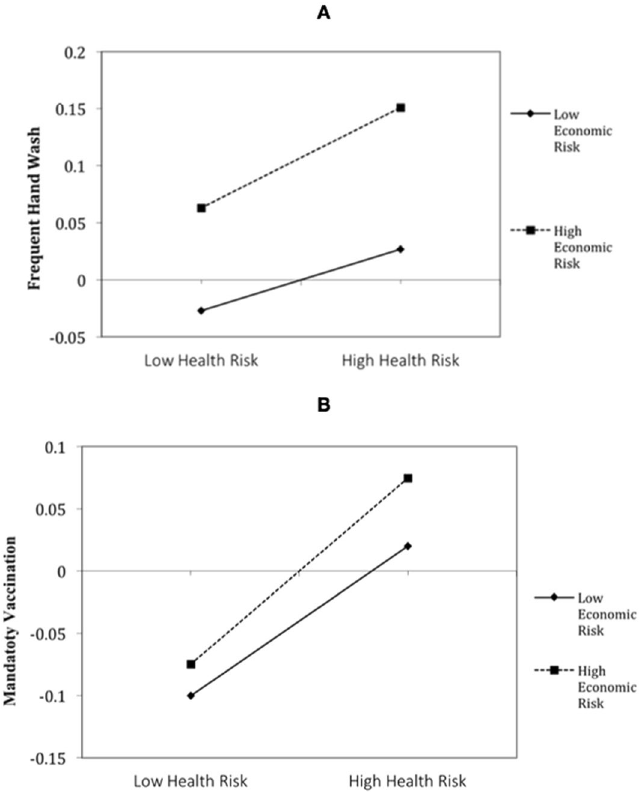
Figure 4. Positive interaction between health and economic perceived risks in their association with frequent hand wash (upper figure A ) and support for mandatory vaccination (lower figure B